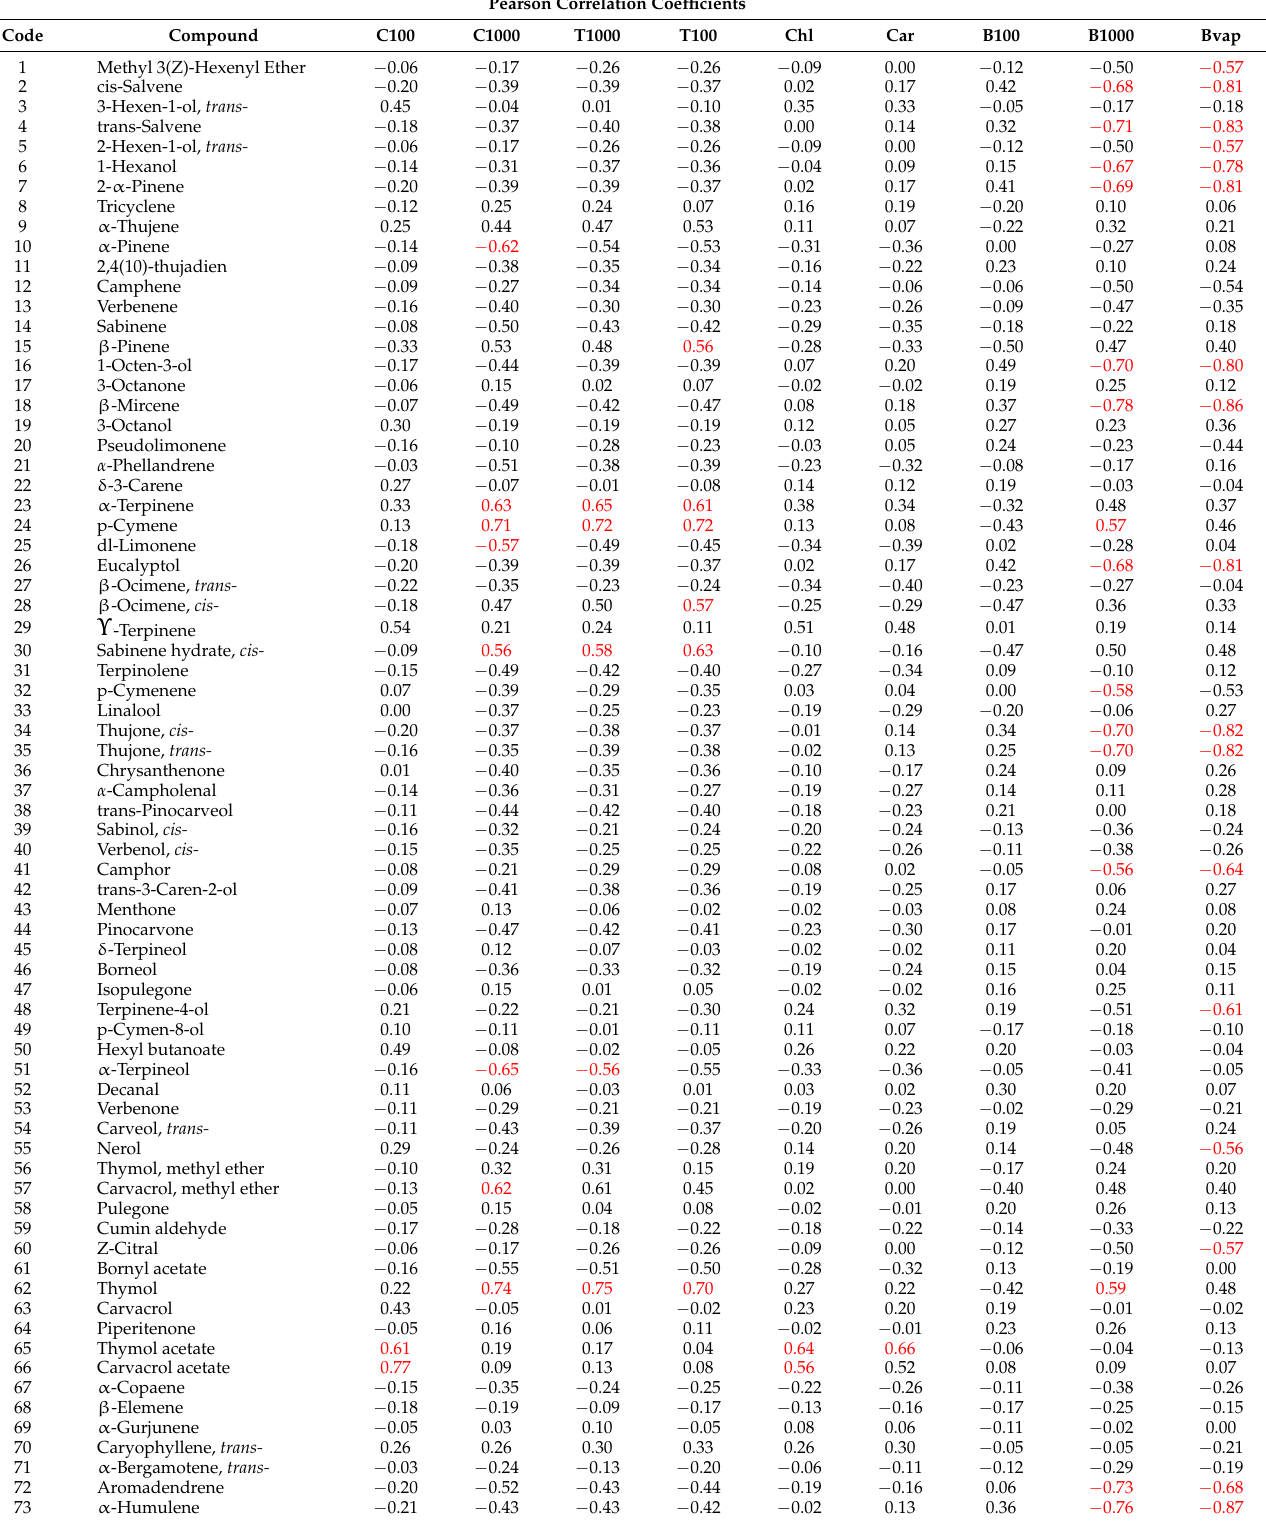
Table 7. Pearson correlation matrix between the chemical composition (%) of EO and the inhibitory biological activity: cress germination with EOs at 100 and 1000 ppm (C100 and C1000), tomato radicle growth with EOs at 100 and 1000 ppm (T100 and T1000), chlorophyll and carotenoid content, broomrape germination with EOs at 100 ppm, 1000 ppm, and vapors (B100, B1000, Bvap). Pearson Correlation